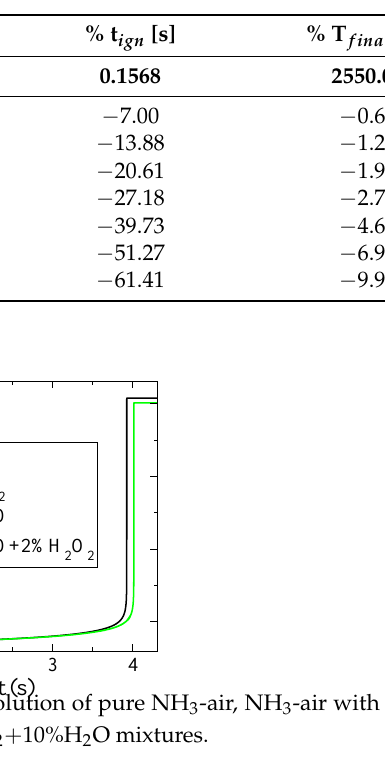
Table 7. Change in ignition delay, final temperature and NO mass fraction of NH 3 -2%H 2 O 2 -air mixture, with various percentages of H 2 O.